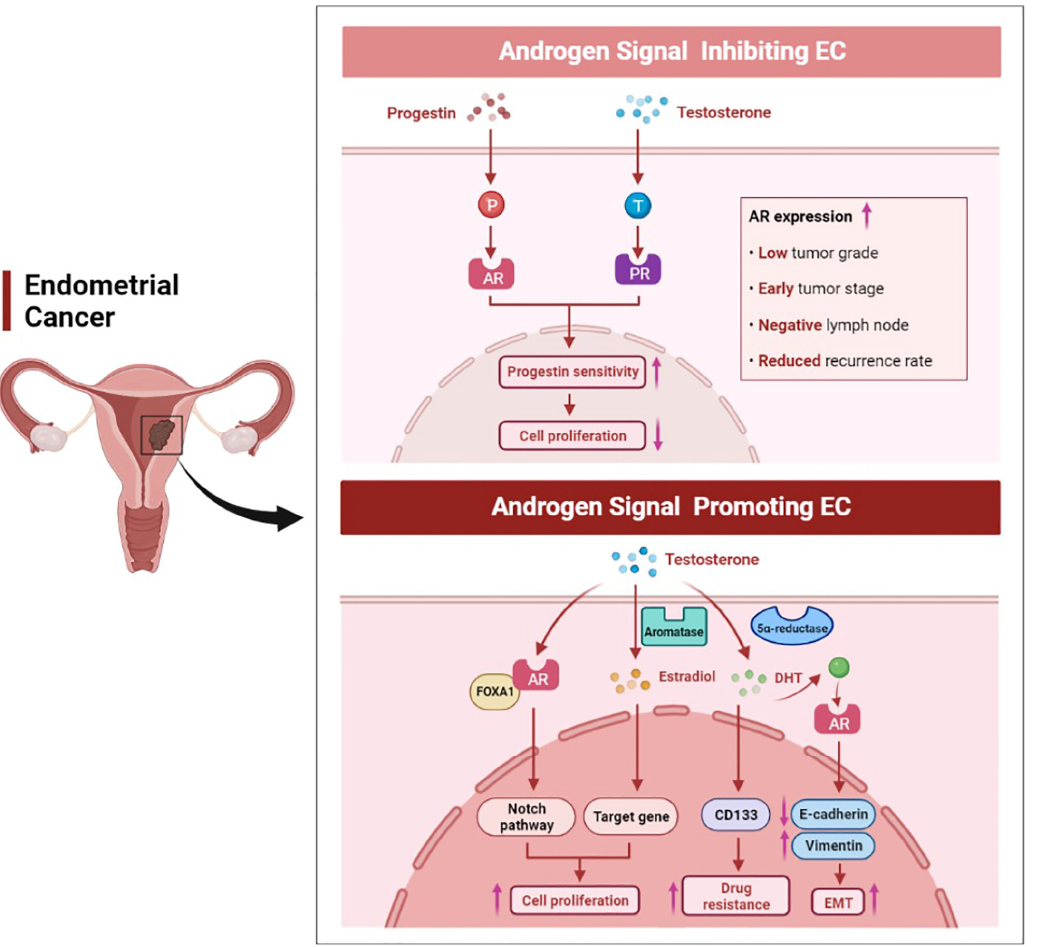
Figure 4. The dual role of androgen signaling in endometrial cancer. High AR expression was positively correlated with a lower grade, early stage, negative lymph node, and lower recurrence rate in EC. Progestin can inhibit tumor growth through AR signaling, and androgen can also bind to PR, thereby enhancing the progestin sensitivity of EC. On the other hand, androgen can promote EC cell proliferation, enhance EMT, and affect the resistance of EC cells to cisplatin.